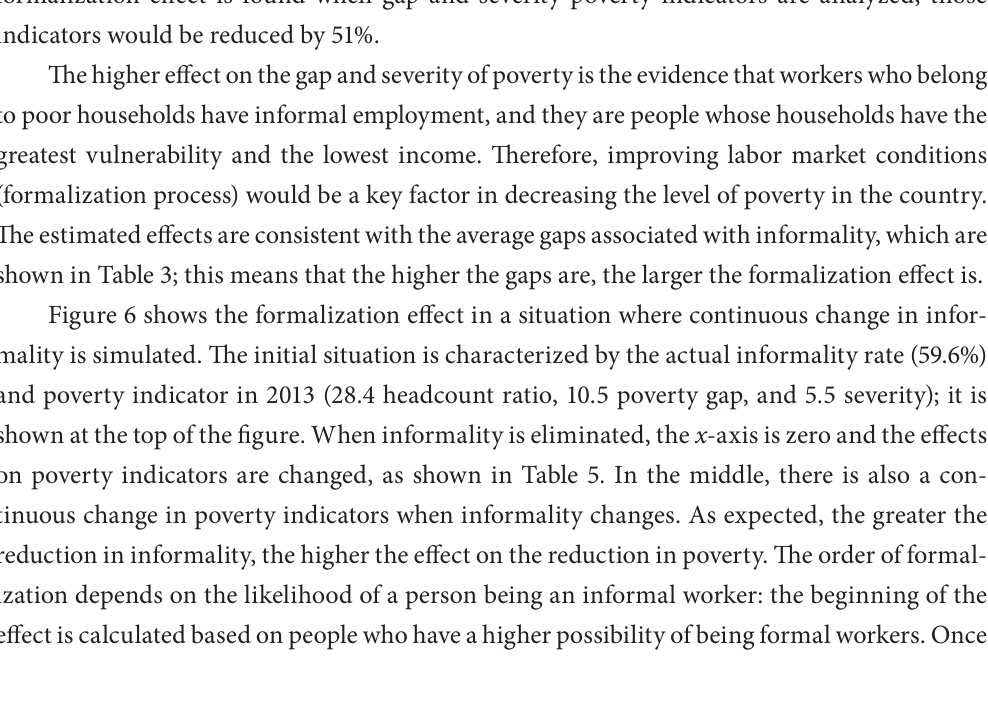
Formalization effect on poverty indicators in Colombia, 2013 Informality